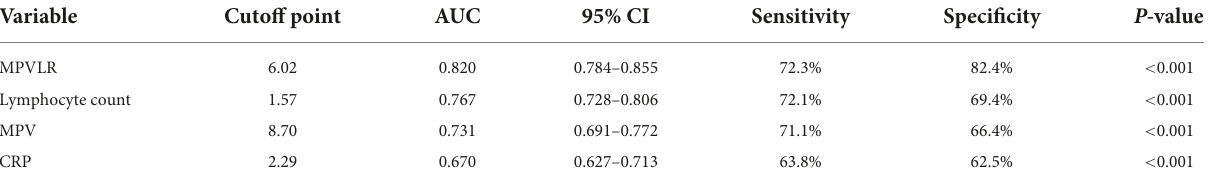
TABLE 5 Receiver-operating characteristic (ROC) curve parameters of MPVLR, MPV, lymphocyte count, and CRP for predicting CCC formation.